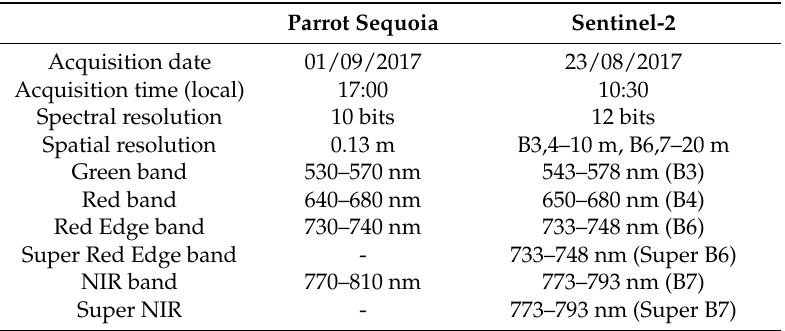
Table 1. Comparison of the characteristics of the Parrot Sequoia and Sentinel-2.